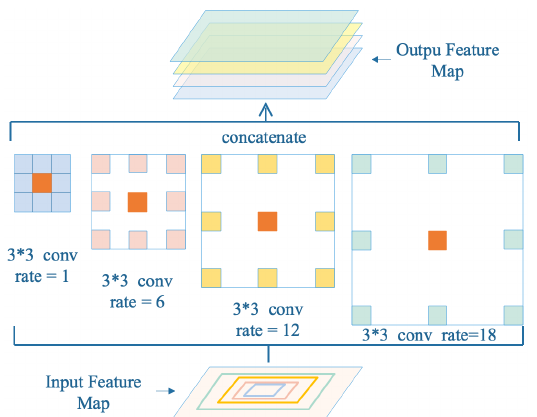
Figure 5. The atrous spatial pyramid pooling (ASPP) model used in receptive field expansion (RFE) module.